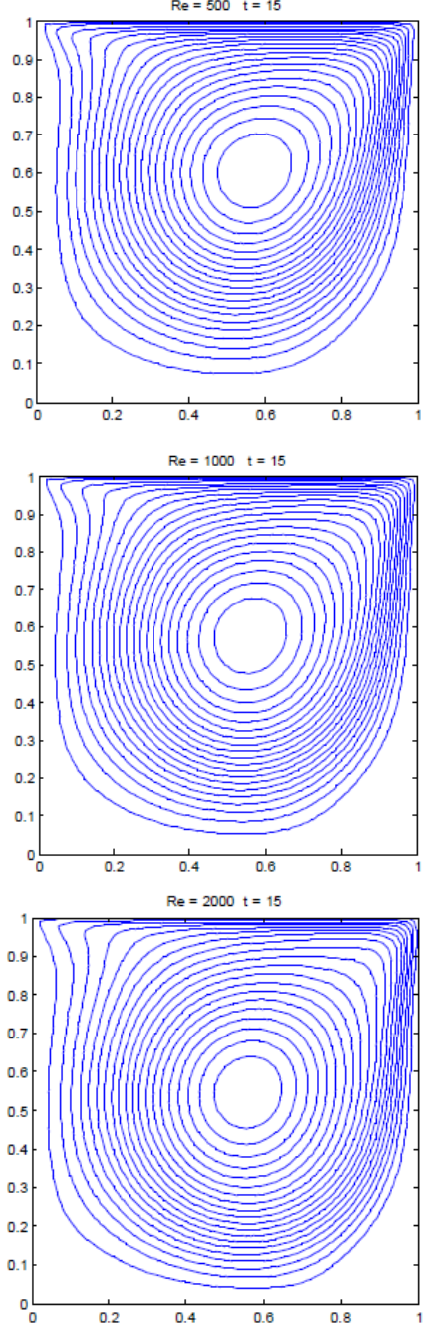
Figure 7. Streamlines for the incompressible flow at t = 15 sec for different values of